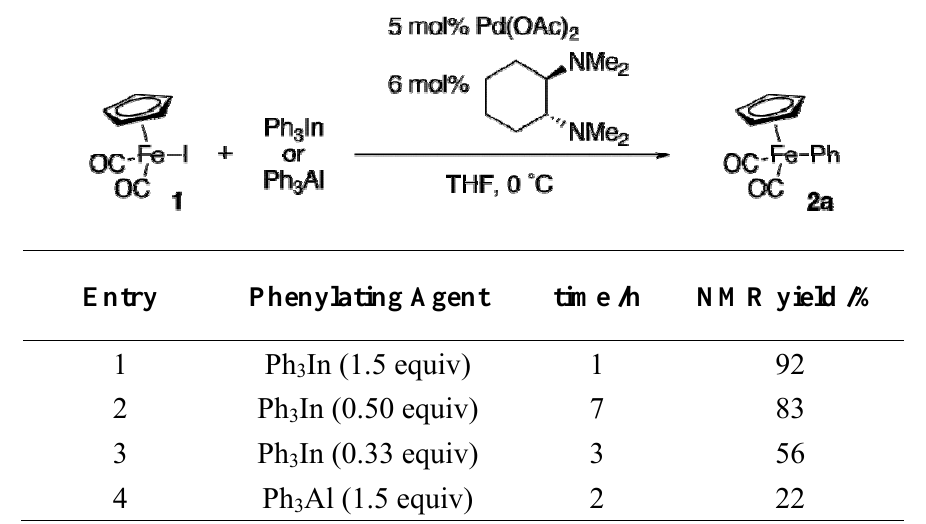
Table 3. Palladium-Catalyzed Phenylation of [CpFe(CO)